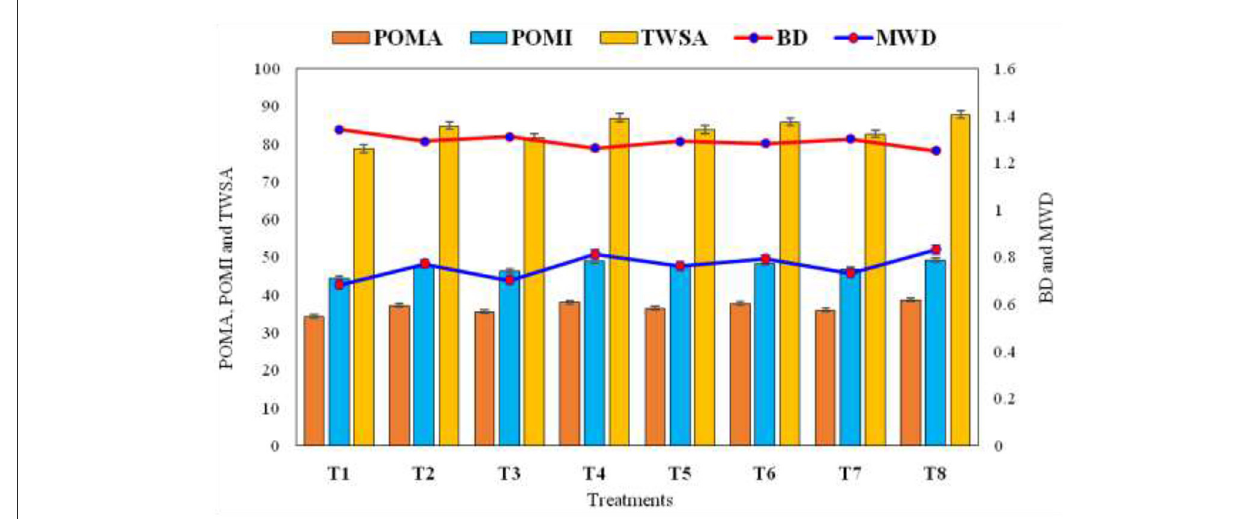
FIGURE3 Effect of the conjoint application of different organic sources of nutrients on the physical properties of the soil after completion of the two years cropping system. POMA, percentage of macroaggregates ( > 0.25mm); POMI, percentage of microaggregates ( < 0.25mm); TWSA, total water-stable aggregates; BD, bulk density (Mg m − 3 ); MWD, mean weight diameter (mm); T1—farmers’ practice (FYM ∼ 50% RDN); T2—100% RDN through FYM; T3—100% RDN through mixed compost (MC); T4—100% RDN through vermicompost (VC); T5—50% RDN through FYM + 50% RDN through MC;